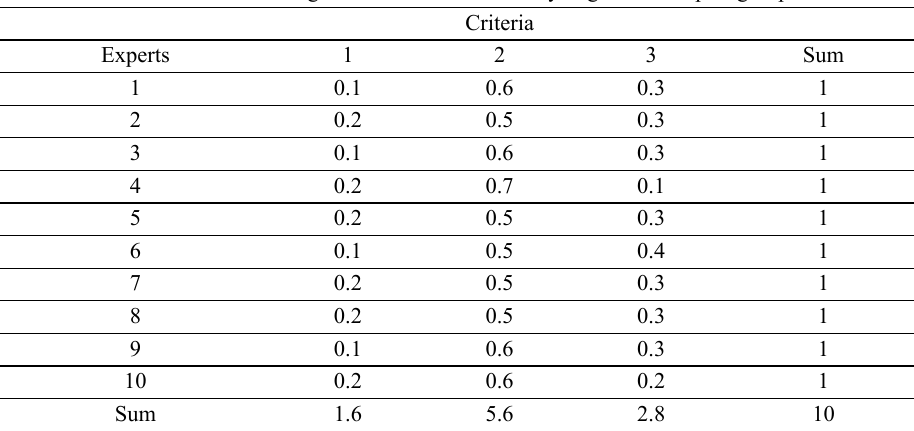
Table A.1. The matrix of the expert evaluation